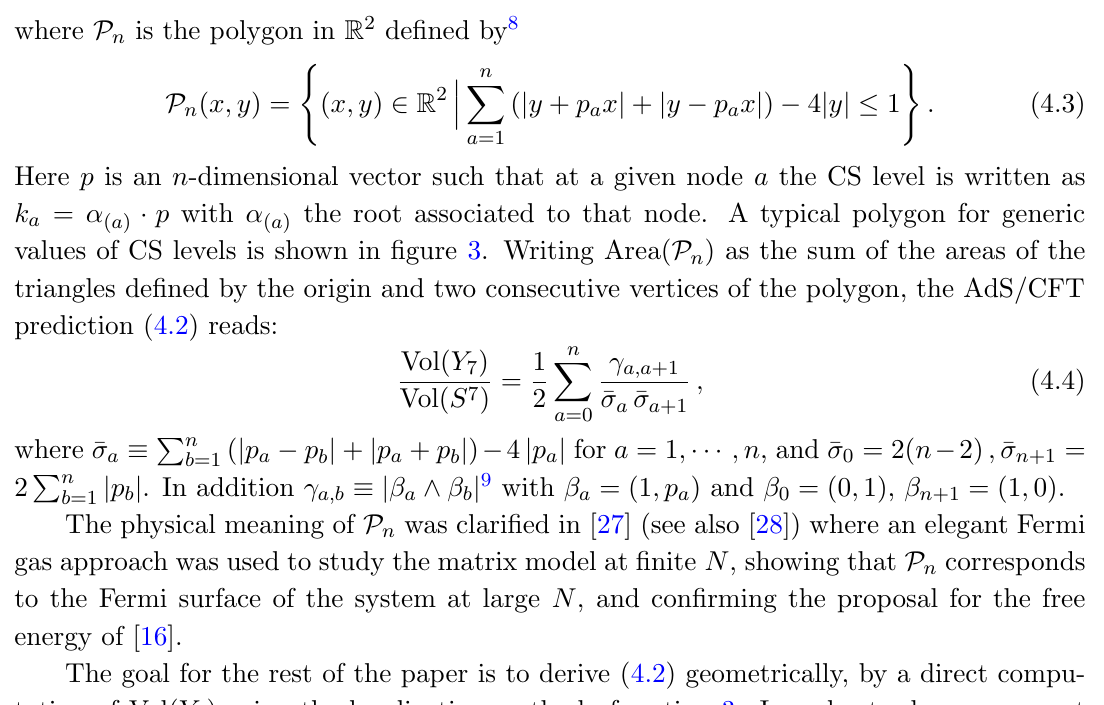
Figure 3 . Schematic form of the polygon P n for the b D n quiver for a generic value of CS levels. Only the upper right quadrant is shown as it is symmetric along both the x and y